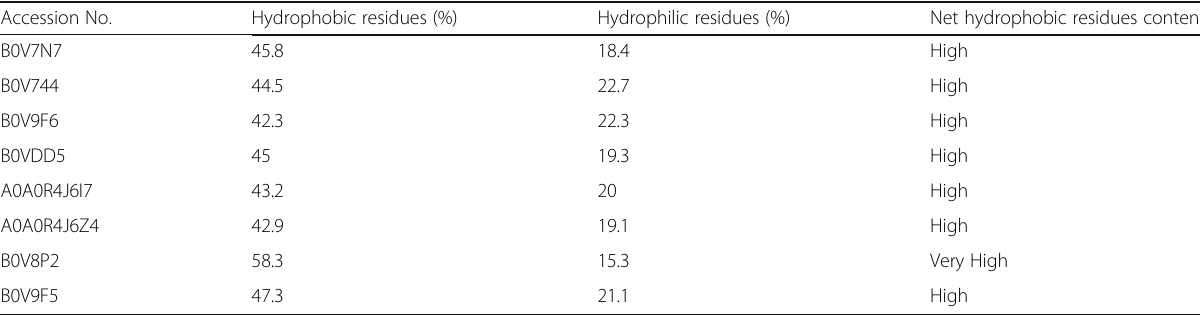
Table 4 Hydrophilic and hydrophobic residues content of eight Mur family proteins from A . baumannii Accession